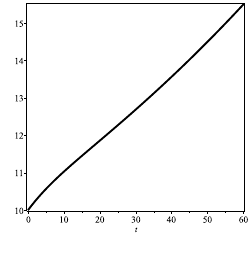
Figure 1. Transitional dynamics for h ( t ) - Chilarescu